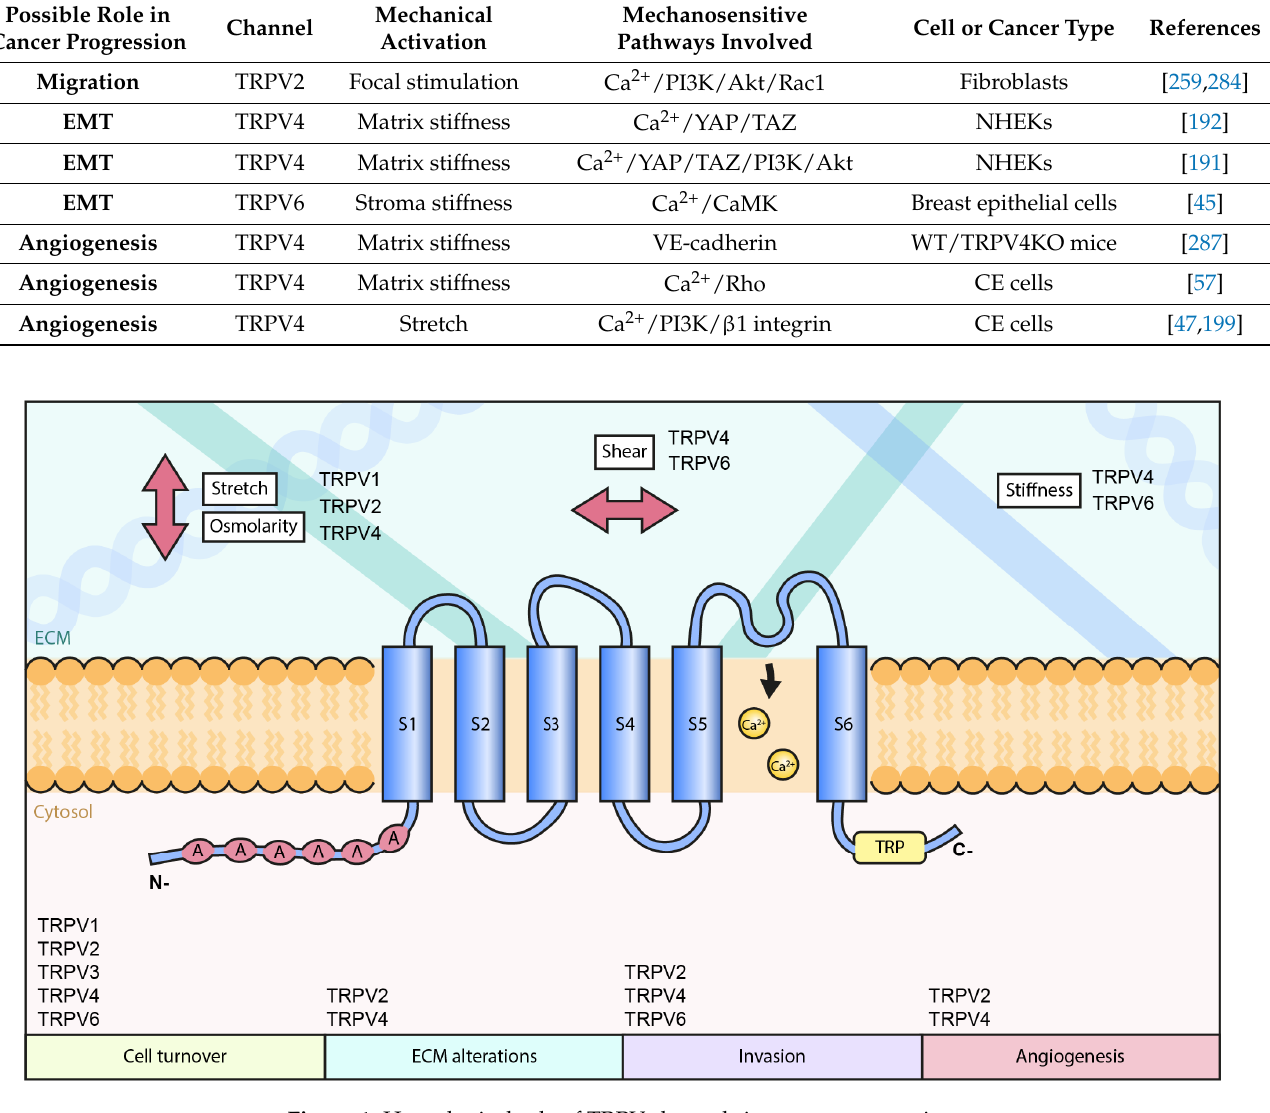
Figure 1. Hypothetical role of TRPV channels in cancer progression. Table 1. Mechanosensitive TRPV channels in cancer progression.